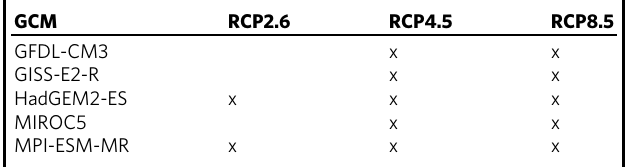
Table 1 Climate models and forcing scenarios selected from the CMIP5 ensemble